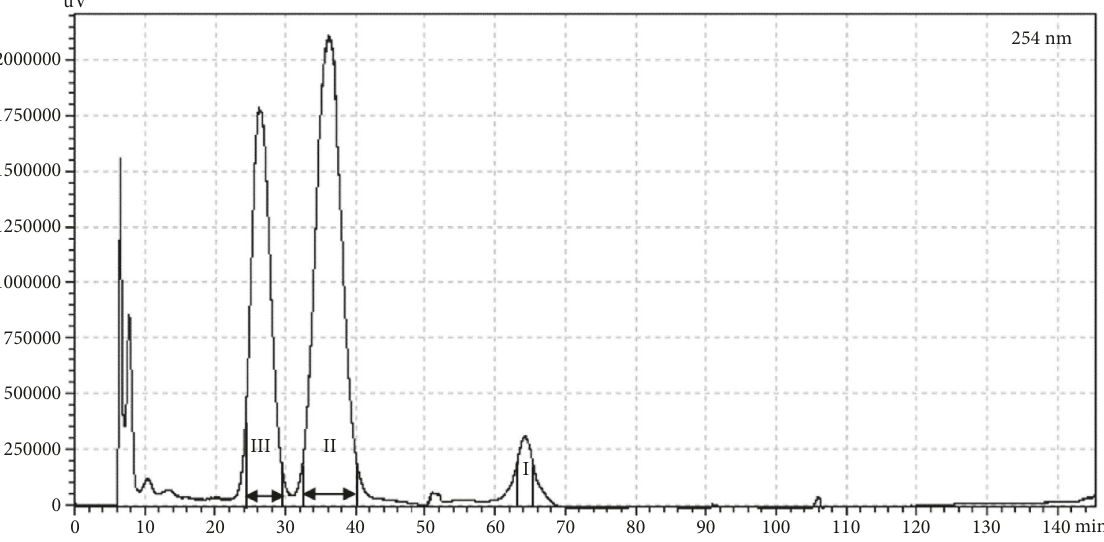
Figure 4: CPC separation of the SC-CO 2 extract of the leaves of P. frutescens var. crispa (cv. Antisperill) using n-hexane/ethyl acetate/ethanol/water(8:2:8:2, v/v) in an ascending mode (for CPC conditions, see Section 2). The extrusion was performed after 42